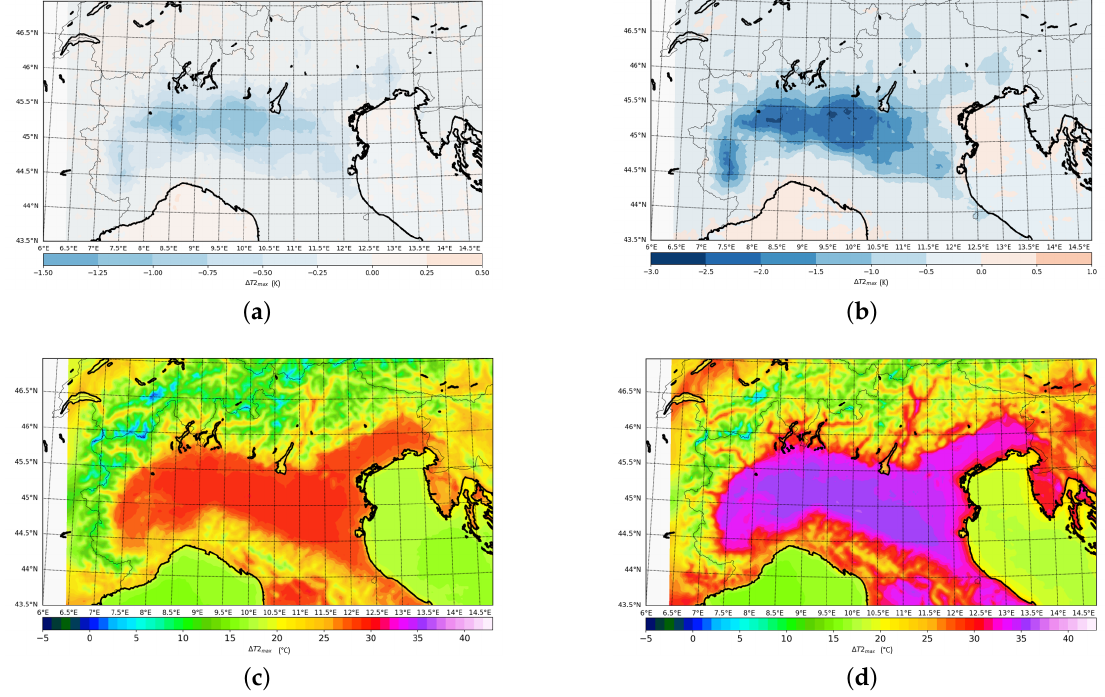
Figure 4. Monthly mean of 2-m temperature daily maximum ( T 2, max ) of the differences between the DRIP and CTRL (upper panel), and the absolute values of CTRL (lower panel), for both June (left) and July (right). ( a ) DRIP ∆ T 2, max June 2015. ( b ) DRIP ∆ T 2, max July 2015. ( c ) Control T 2, max June 2015. ( d ) Control T 2, max July